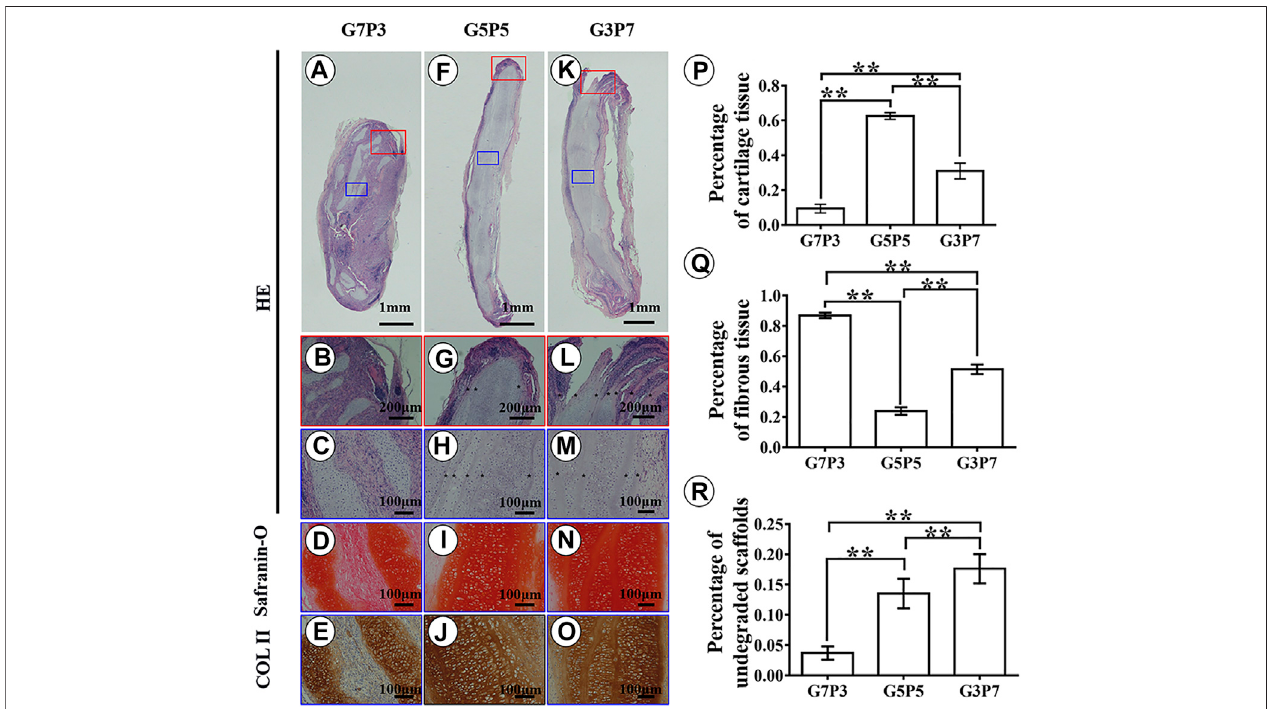
FIGURE4| Histologicalexaminationand semiquantitativeanalysisinengineeredtissuesat3 weeks invivo .IntheG7P3group,the samplesshow sparsecartilage islands surrounded by abundant in fl ammatory cells, fi brous tissue, and discontinuous laminar scaffolds (A – E) . In the G5P5 and G3P7 groups, relatively homogenous cartilage is observed in the interior regions (blue box) of the samples with typical lacuna structure and positive staining of GAG and type II collagen (H – J,M – O) , and continuous undegraded lamellar scaffolds (marked with *) are still observed among neocartilage (H,M) . At the edge of the samples (red box), the G5P5 group shows relatively homogenous cartilage formation with fi ne interlayer integration and no obvious fi brous tissue invades toward the interior of the sample (G) . In the G3P7 group, relatively inferior tissue integration is observed at the edge of the samples and obvious fi brous tissue invades toward the interior of the sample along with the interlayer gap (L) .The semiquantitative analysisshows signi fi cantdifferences inarea percentage ofcartilagetissue, fi brous tissue, and undegraded scaffolds among the three groups (P – R) . *Indicating signi fi cant differences (* p < 0.05; ** p < 0.01).